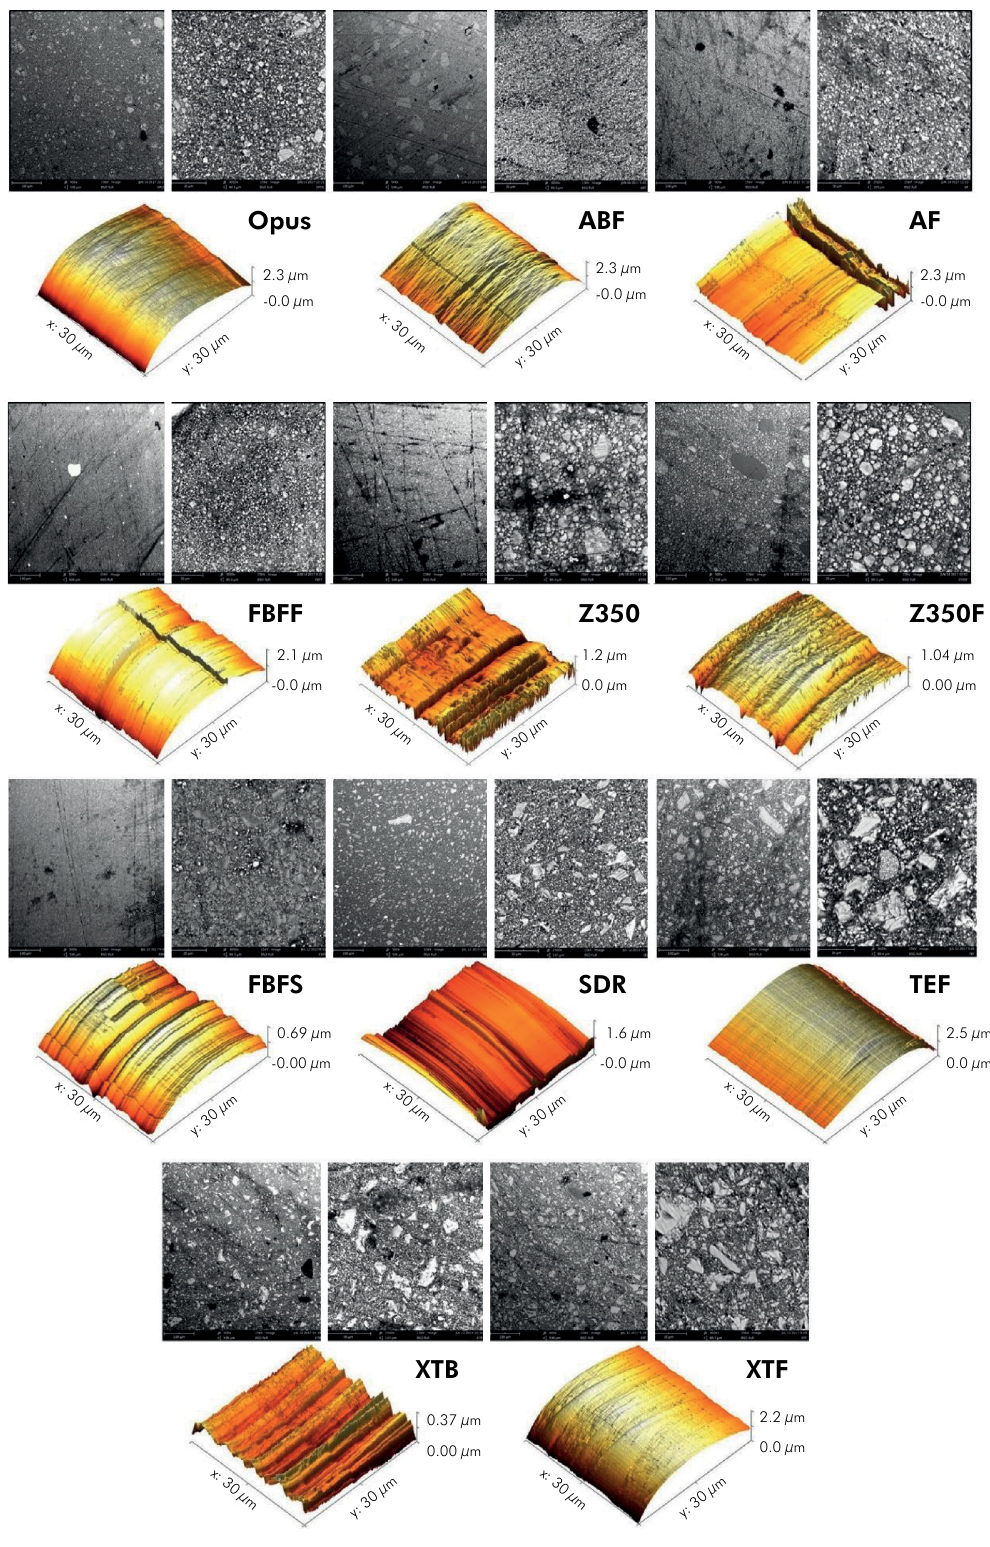
Figure 1. Image representative of the surface morphology (SEM/AFM) of the materials after finishing and polishing with soft-lex discs. SEM images at 500 and 3000X